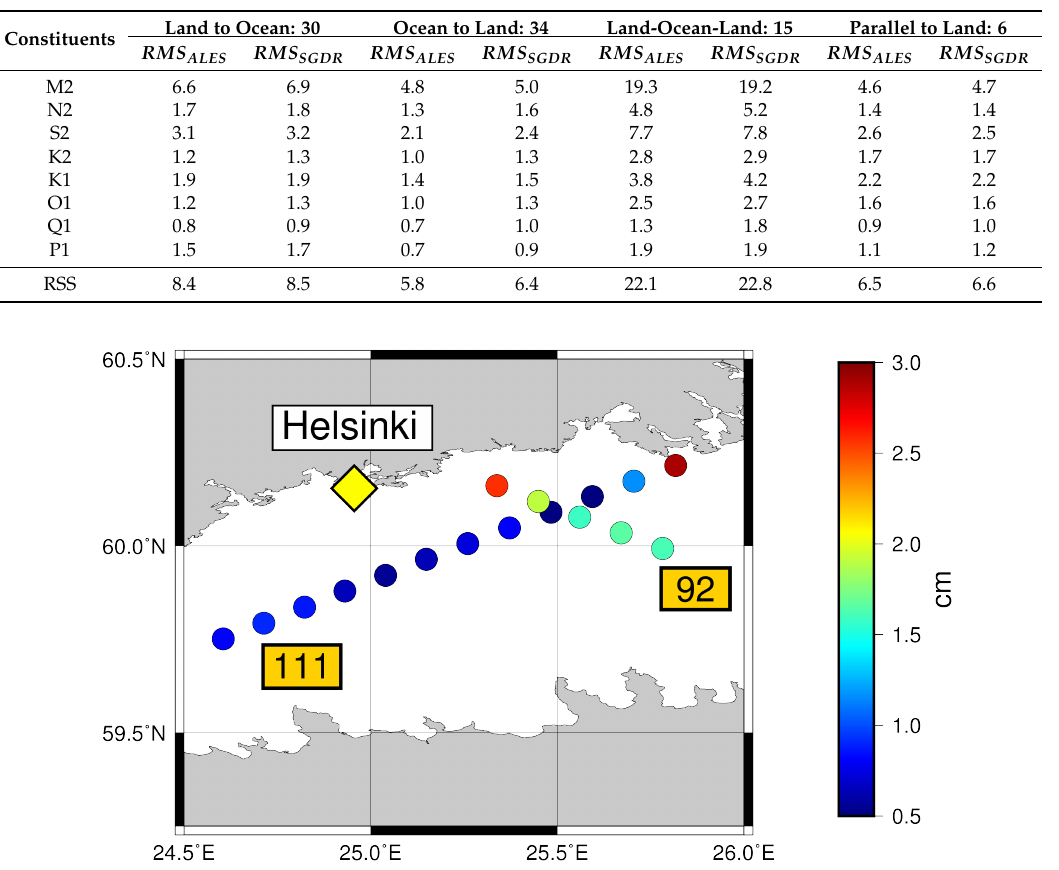
Table 3. Average of RMS computed for major constituents at the closest points to the tide gauges. The averages are computed after dividing the tracks according to their position with respect to the coast. The values are in cm.